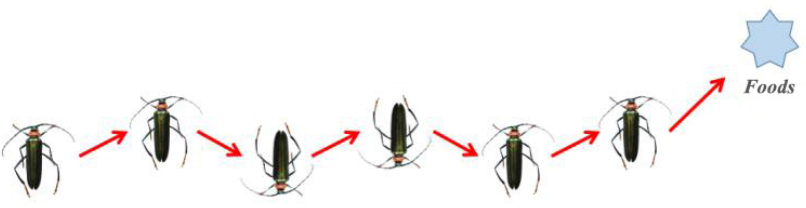
Figure 1. Feeding behavior of beetles.